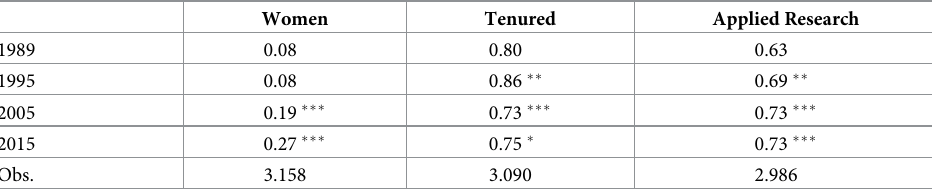
Table 3. Sample/Faculty composition change across